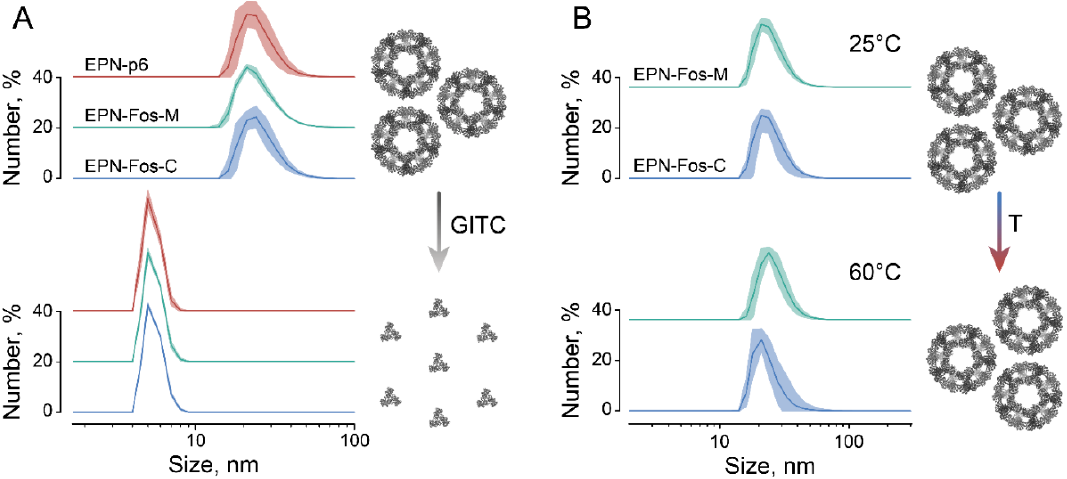
Figure 2. The stability of protein EPN nanocages containing Fos domain. ( A ) DLS experiments reveal measured hydrody- namic diameter of EPN-p6 (24.3 ± 1.0 nm), EPN-Fos-C (25.8 ± 0.7) and EPN-Fos-M (24.8 ± 0.2) (n = 3). After overnight incubation under denaturing conditions (3 M GITC) protein nanocages disintegrated into monomers. ( B ) Modified protein nanocages with Fos domain can withstand heating up to 60 °C.